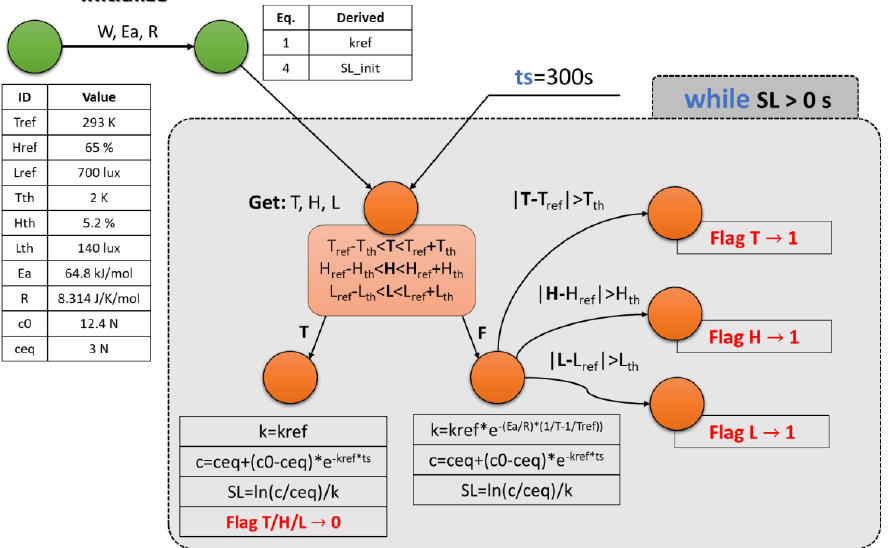
Figure 5. Monitoring and control protocol flowchart from the initialization to the control flag definition. The initialization stage is shown by green circles, while the cycle body is represented by orange circles.